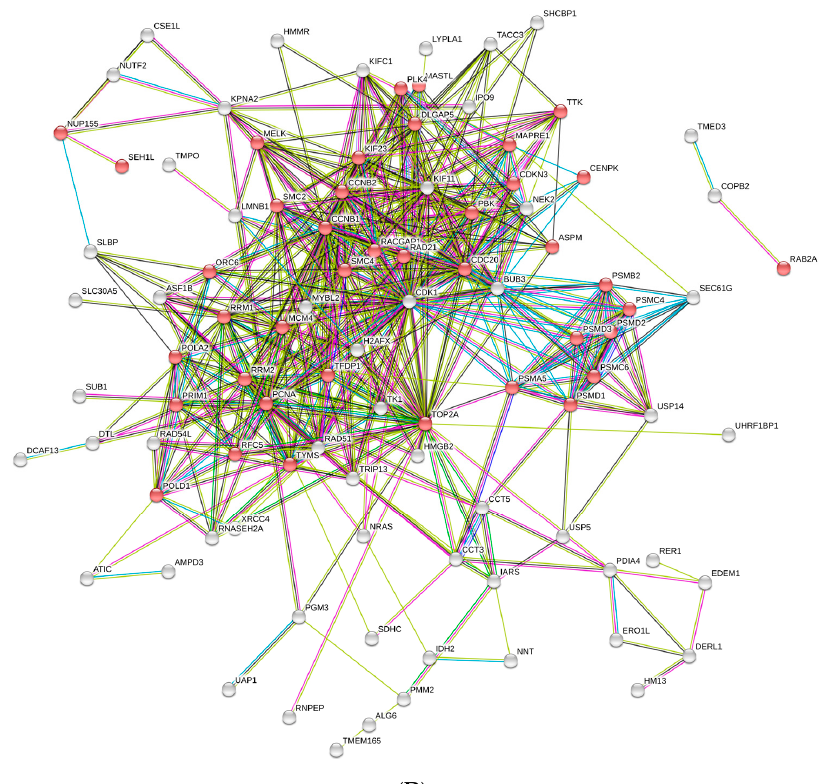
Figure 2. Comparison of gene expression profiles between E2-treated zebrafish and human breast cancer. ( A ) Venn diagram showing the overlap between differentially expressed genes of E2-treated zebrafish and human breast cancer at different time points after E2 treatment: 12 h (N), 24 h (O), 48 h (P); ( B ) Direction of regulation of common differentially expressed genes of zebrafish at different time points after E2 treatment and of human breast cancer. Graphs represent the number of regulated genes; ( C ) Enriched gene ontology (GO) terms of common differentially-expressed genes to E2-treated zebrafish and human breast cancer, as were identified using the DAVID functional annotation tool. Shown are significant –log2 Benjamini p -values of the biological process terms of differentially expressed genes at 12, 24 and 48 h; ( D ) Gene network of the common up-regulated genes to 48 h E2-treated zebrafish and human breast cancer. Presented is the most enriched “mitotic cell cycle” biological process GO term GO: 0000278 (41 out of 118 common upregulated genes), as was identified and visualized by the STRING database. The 41 common upregulated mitotic cell cycle genes are marked with red circles.